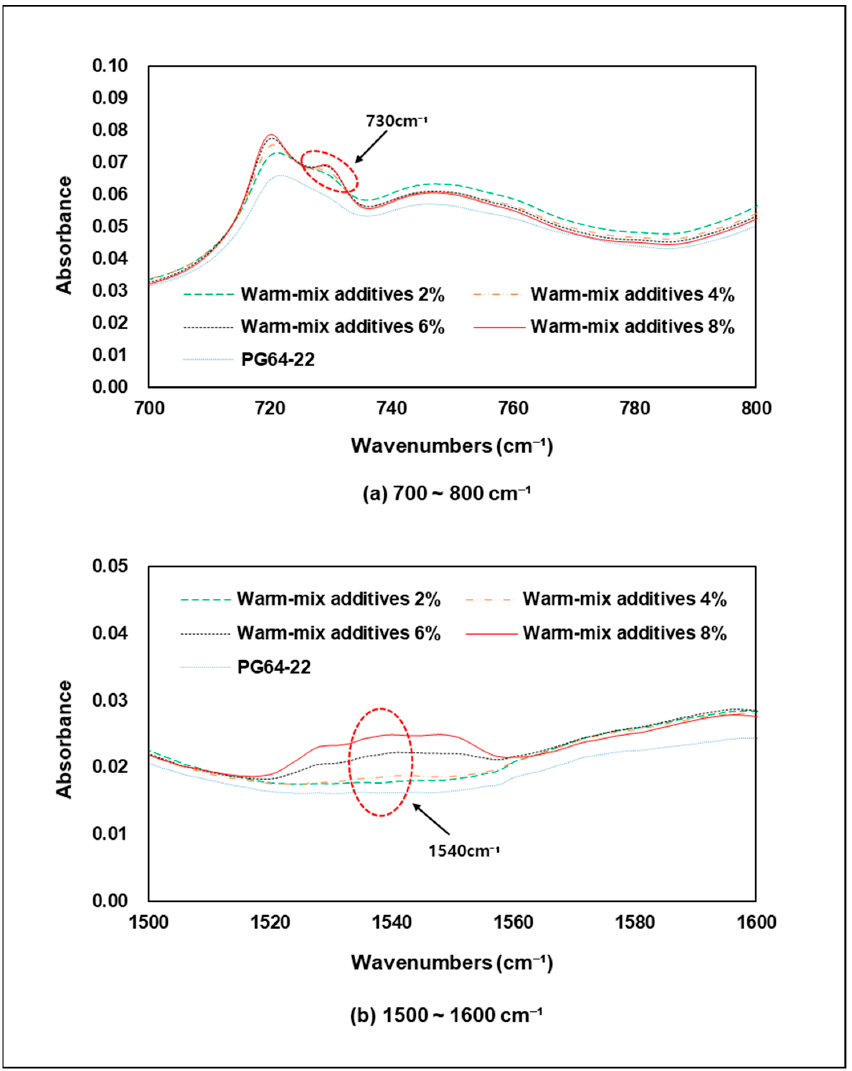
Figure 15. Peak wavenumber of warm-mix additives modified asphalt binder.